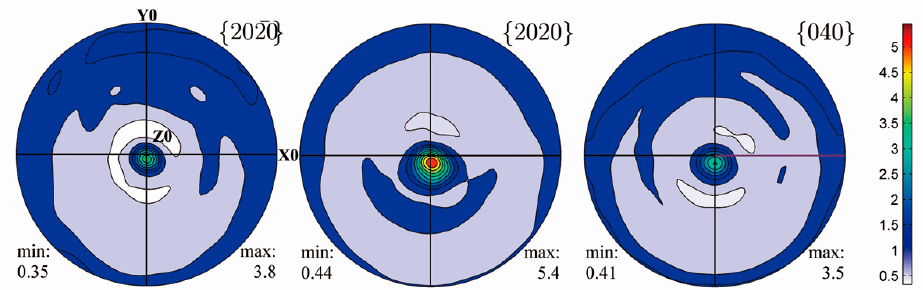
Figure 9. {2 0 − 20} 7M , {2 0 20} 7M , and {0 4 0} 7M pole figures recalculated from the X-ray diffraction (XRD) measurements for Ni 51 Mn 27 Ga 22 ribbons [52]. X0//ribbon length (rolling) direction, Z0 ⊥ ribbon plane. According to the orientation relationship between austenite and 7M martensite [37], i.e., {1 0 1} A //{1 − 2 − 10} 7M and <1 0 − 1> A //< − 10 − 10 1> 7M , the crystallographic correlation between austenite and